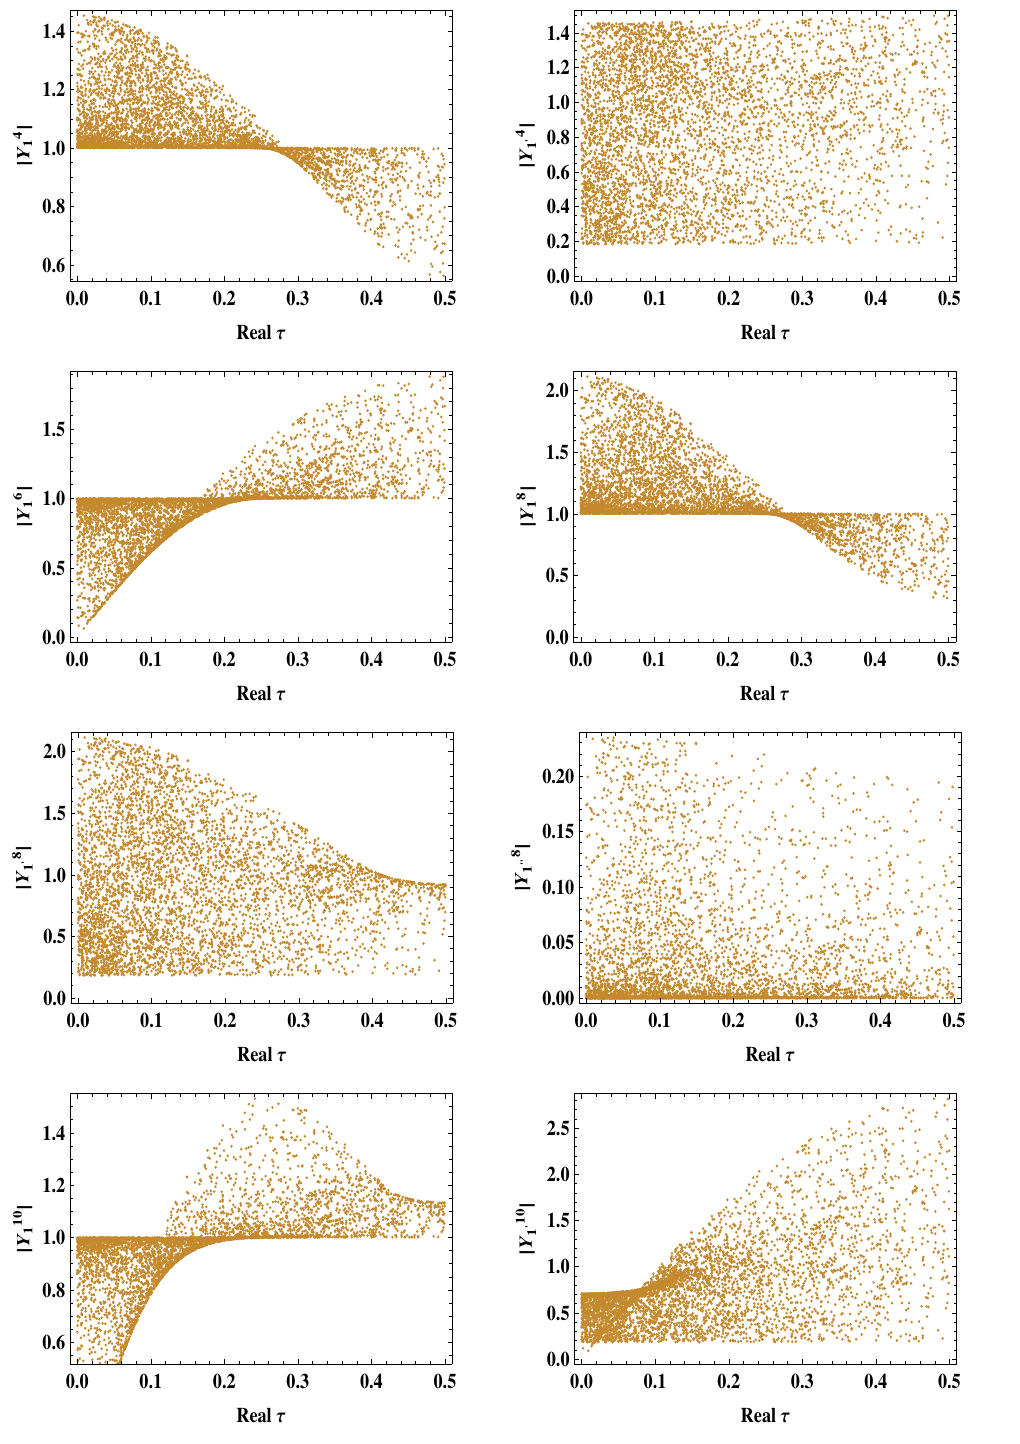
Figure 2 . Variation of Yukawa couplings of higher modular weight with real part of complex modulus τ